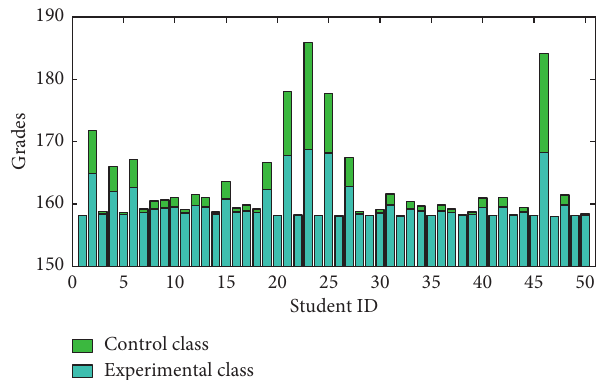
Figure 5: Test for the difference of the pretest results between the experimental class and the control class.